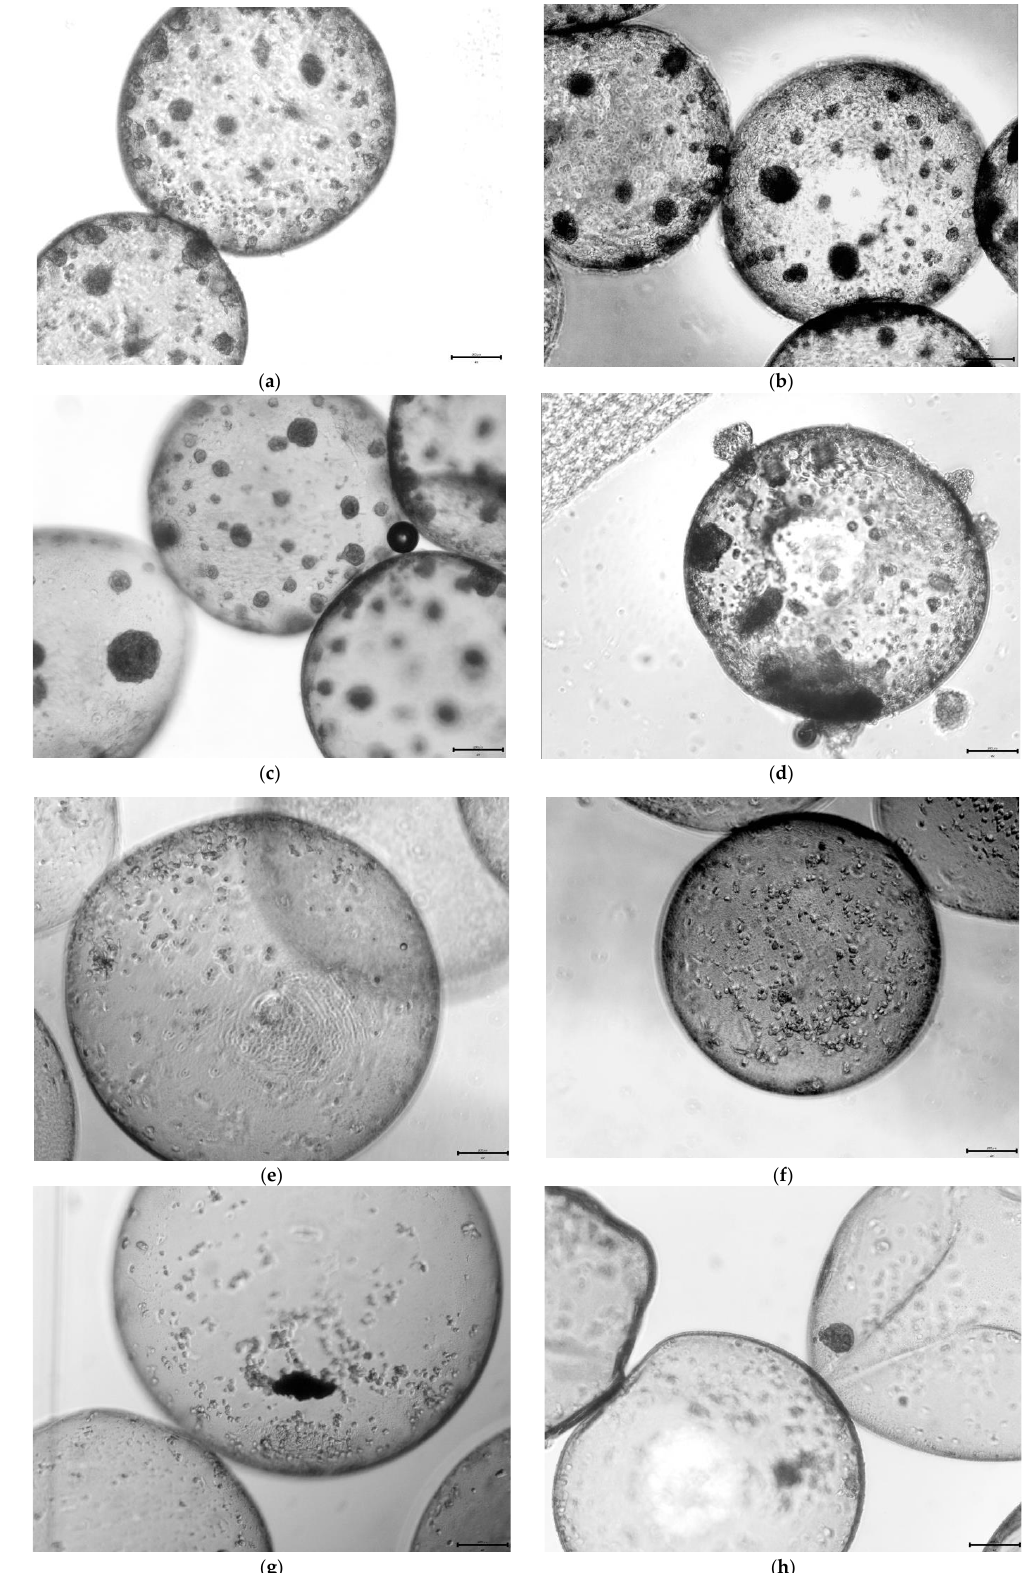
Figure 7. Brightfield images of 28-day chondrocyte and bMSC encapsulated cultures. ( a ) Chondro- cytes day 7; ( b ) chondrocytes day 14; ( c ) chondrocytes day 21; ( d ) chondrocytes day 28; ( e ) bMSC day 7; ( f ) bMSC day 14; ( g ) bMSC day 21; ( h ) bMSC day 28.